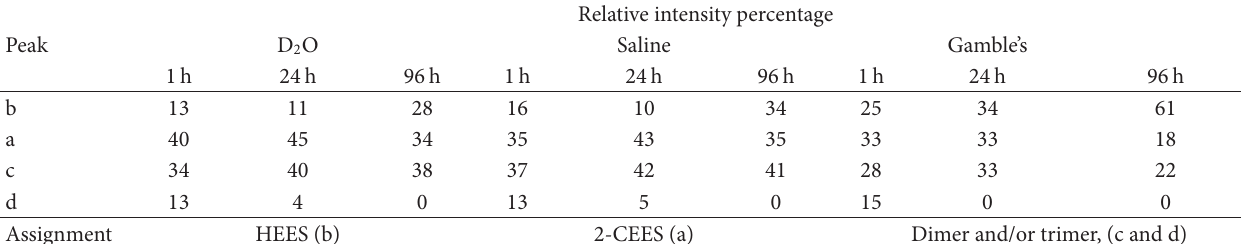
T 3: Comparison of methyl-peak intensities of 2-CEES reaction